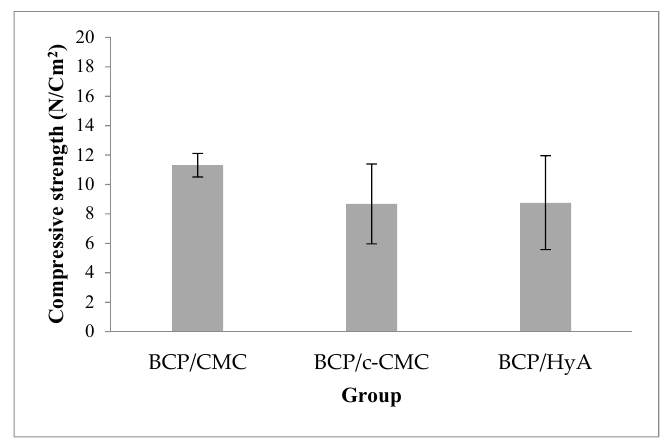
Figure 6. Compressive strengths of the experimental groups. No significant intergroup difference was observed ( p > 0.05; n = 5).